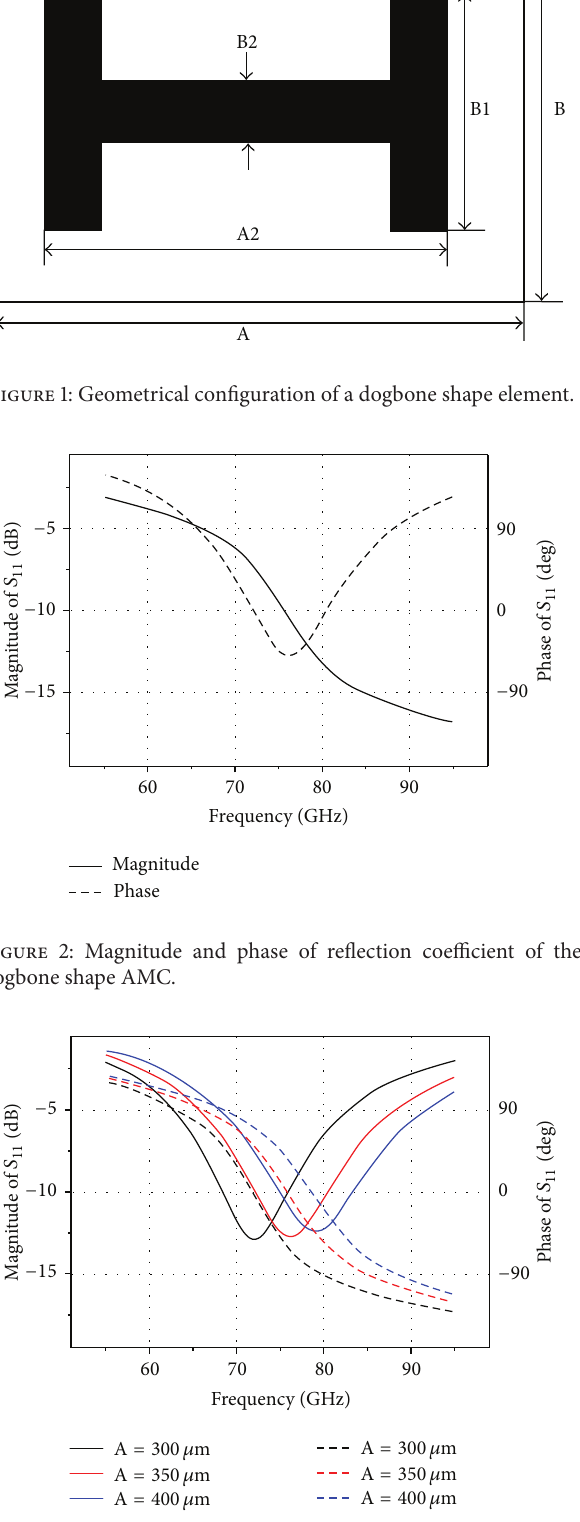
Figure 3: Magnitude and phase of reflection coefficient versus geometrical parameter A of the proposed AMC.